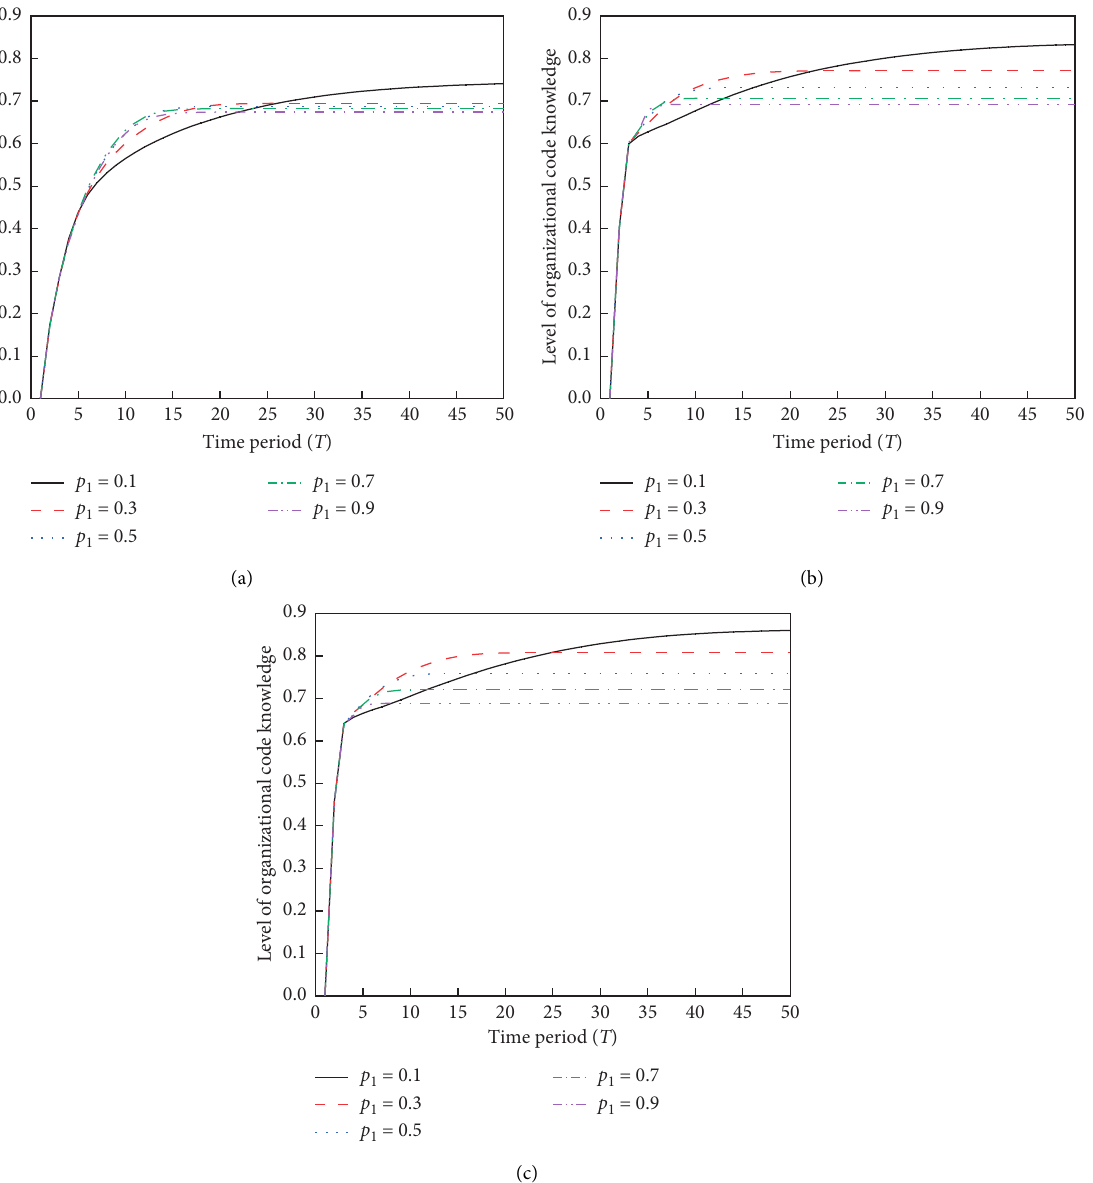
Figure 3: Effects of the socialization rate ( p 1 ) on the level of organizational code knowledge at different codification rates ( p 2 ) over time in the stable environment ( p 4 � 0) and closed system ( p 3 � 0). (a) p 2 � 0.1. (b) p 2 � 0.5. (c) p 2 �